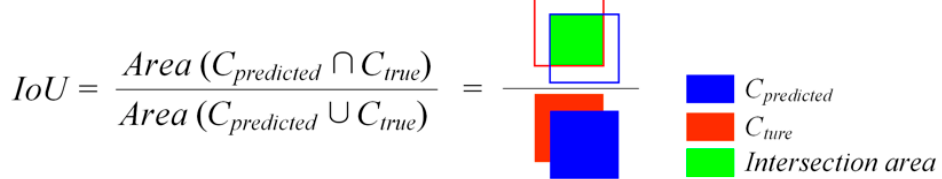
Figure 6. Diagram of IoU calculation process. C true is the ground-truth of the crown polygons, C predicted is predicted crown polygons.The performance of the Mask R-CNN and ACE R-CNN was